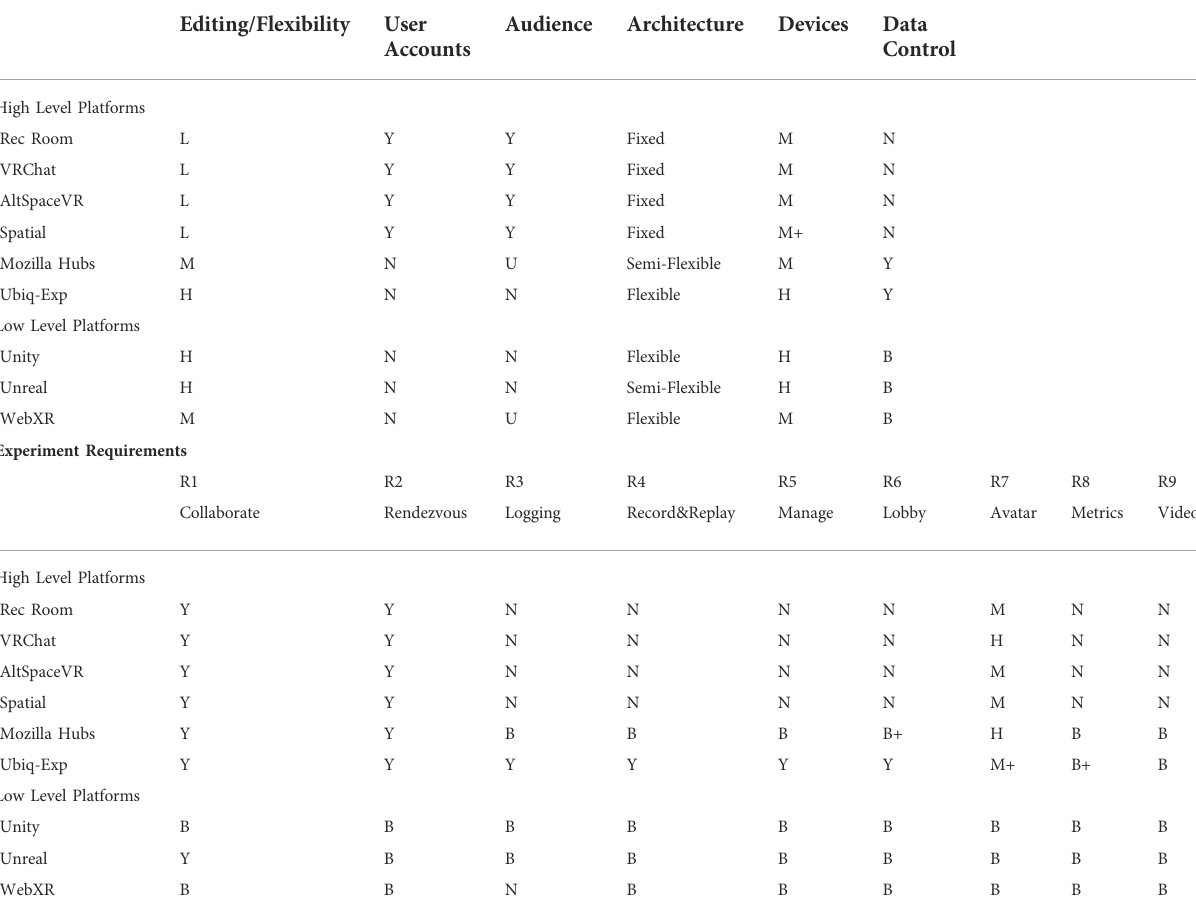
TABLE 3 Analysis high-level and low-level platforms against general requirements of building experiment content and the speci fi c requirements of distributed and remote